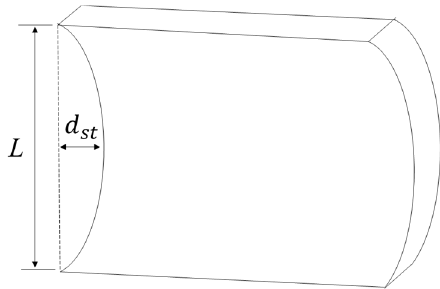
Figure 5. Measurement of straightness 𝑑 (cid:3046)(cid:3047) of a structural element